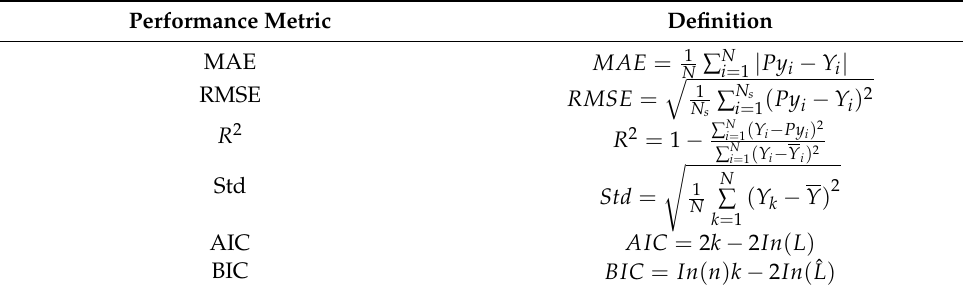
Figure 3. First study area: the Masila basin oilfield, Yemen. Table 1. Performance